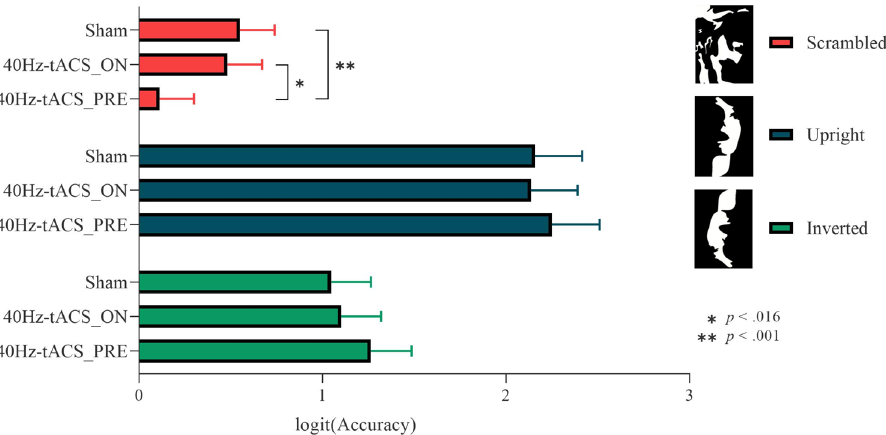
Figure 5. Group*Response interaction for the Mooney test for faces. Post-hoc contrasts based on Group. Participants in the 40Hz-tACS_PRE group exhibited worse performance in terms of accuracy for scrambled stimuli, which were more often misperceived as faces than in the Sham and 40Hz-tACS_ON groups (i.e., induced offline pareidolia